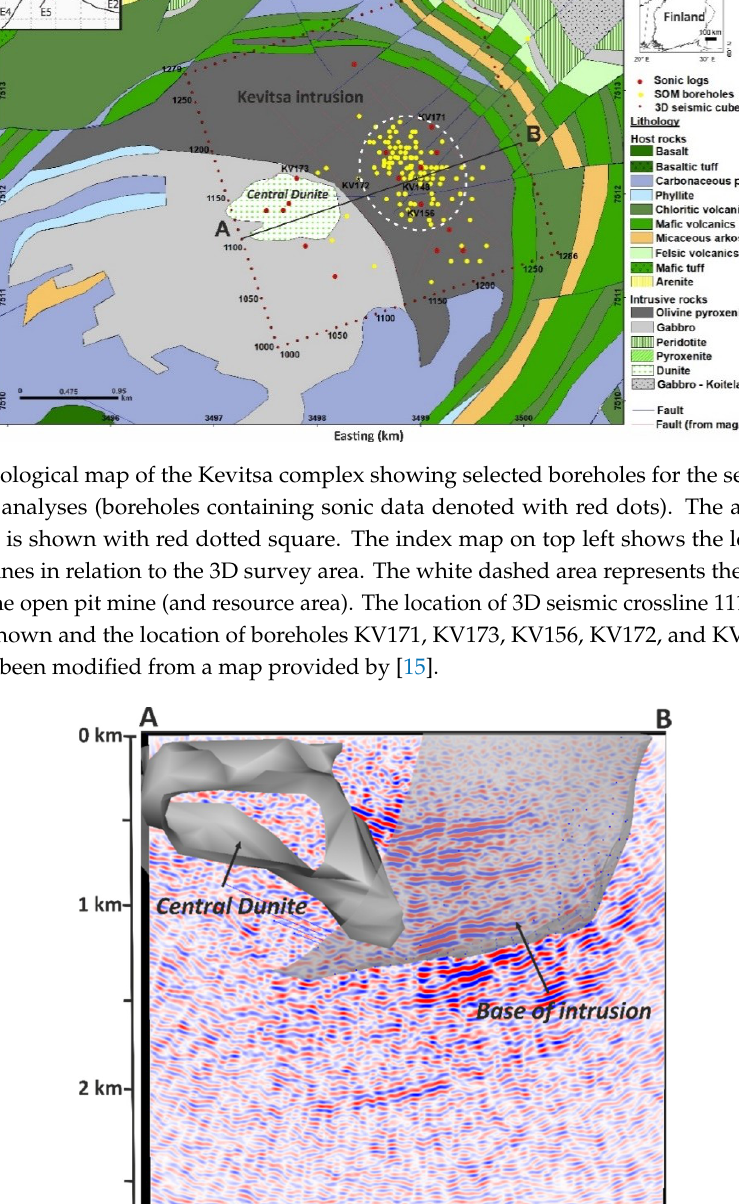
Figure 3. Schematic drawing showing gradational (i.e., no hard boundaries exist within an individual layer) mineralogical trends within the olivine pyroxenite magma layers that were earlier suggested to control the extent of the economic mineralization and form smaller-scale magmatic layering within the Kevitsa intrusion (modified from [21,22]). The layers were suggested to represent a spectrum of olivine pyroxenites consisting of plagioclase (PLAG) and orthopyroxene (OPX) rich tops (i.e., plagioclase-bearing olivine websterite) that grade into more olivine (OL) and clinopyroxene (CPX) rich bottoms (i.e., olivine pyroxenite). In this model, the mineralization is more strongly associated with the bases of the individual layers. The contacts between tops and bottoms of successive pulses were expected to be sharp. Typical thickness of one layers is tens to hundreds of meters.